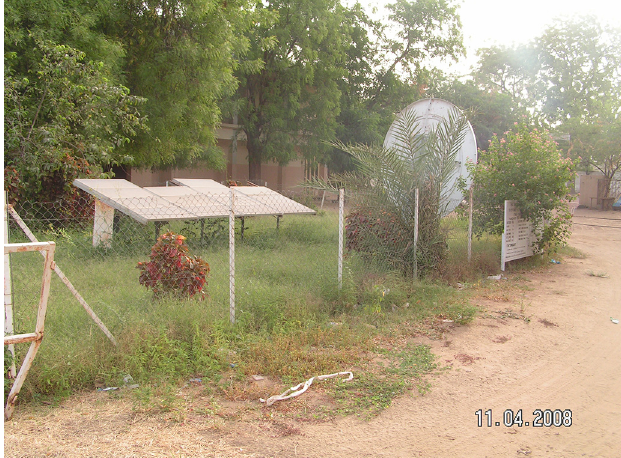
Fig. 7. Shade from trees in a solar pumping system in Ndjamena (cid:1) Chad (photo J.